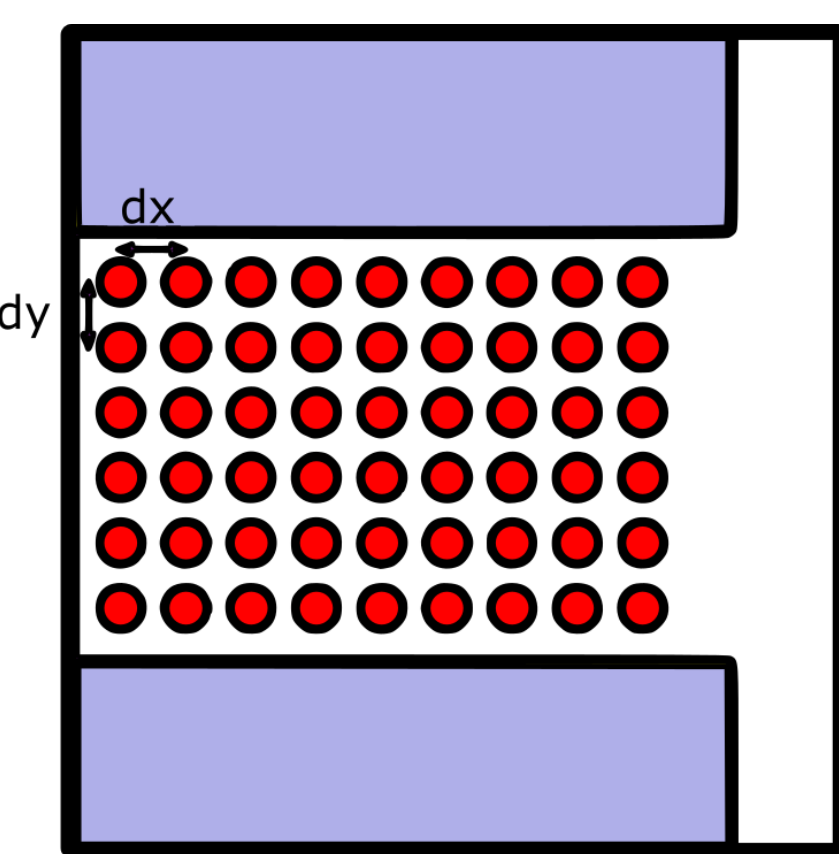
Figure 2. Training and interpolating the genetic algorithm (GA).